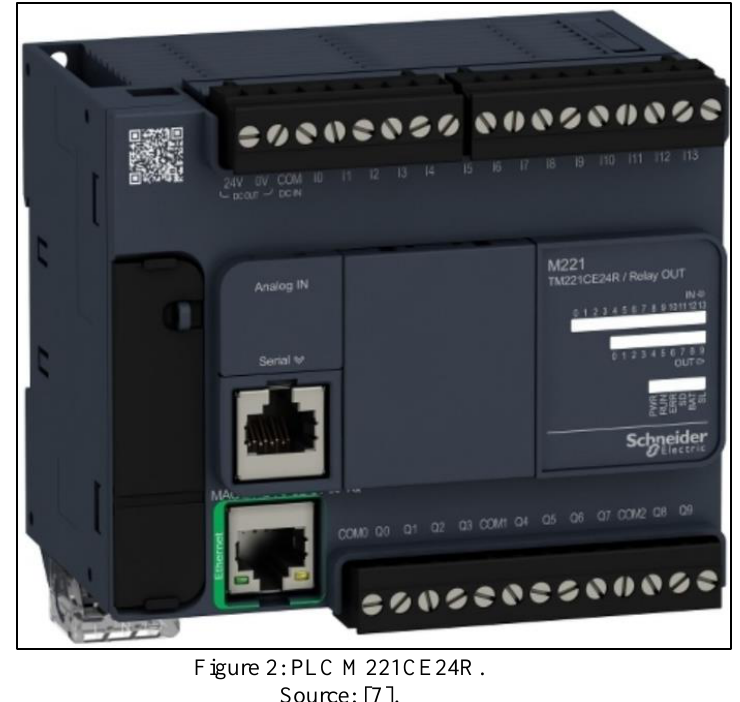
Figure 2: PLC M221CE24R. Source: [7].